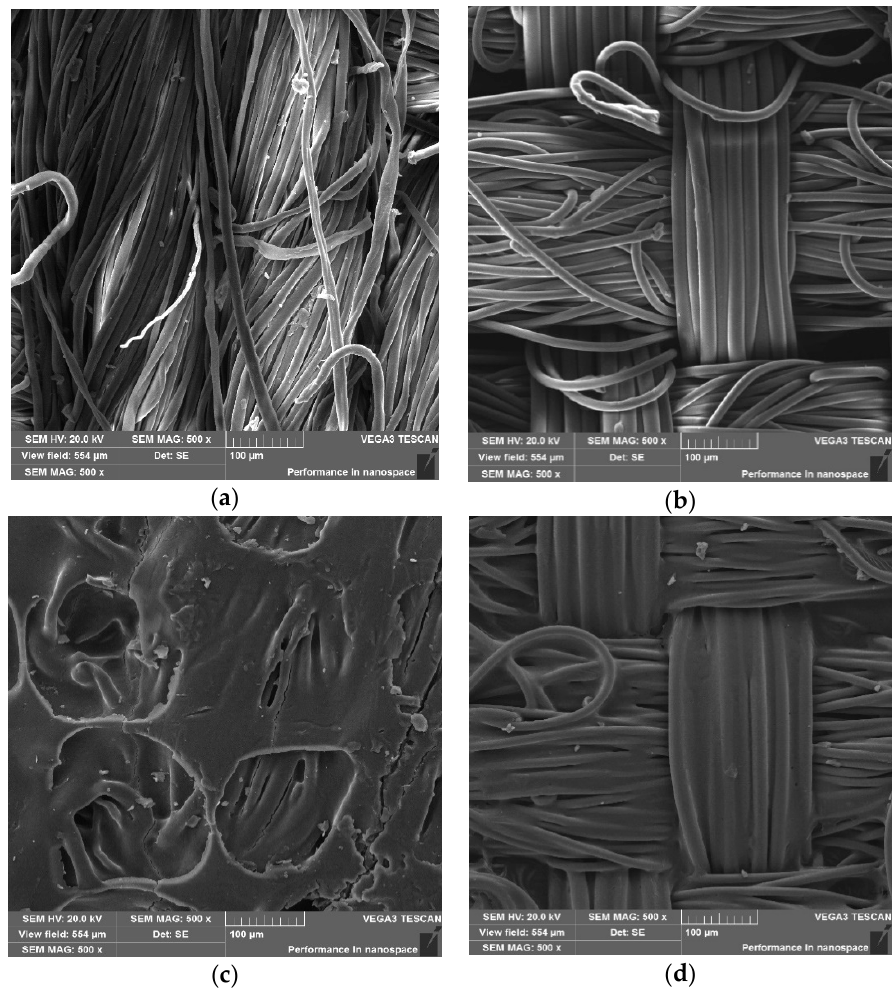
Figure 9. SEM images of the non-printed cotton fabric ( a ), non-printed polyamide fabric ( b ), cotton fabric printed with NBT-Pluronic F-127 hydrogel ( c ) and polyamide fabric printed with NBT-Pluronic F-127 hydrogel ( d ).